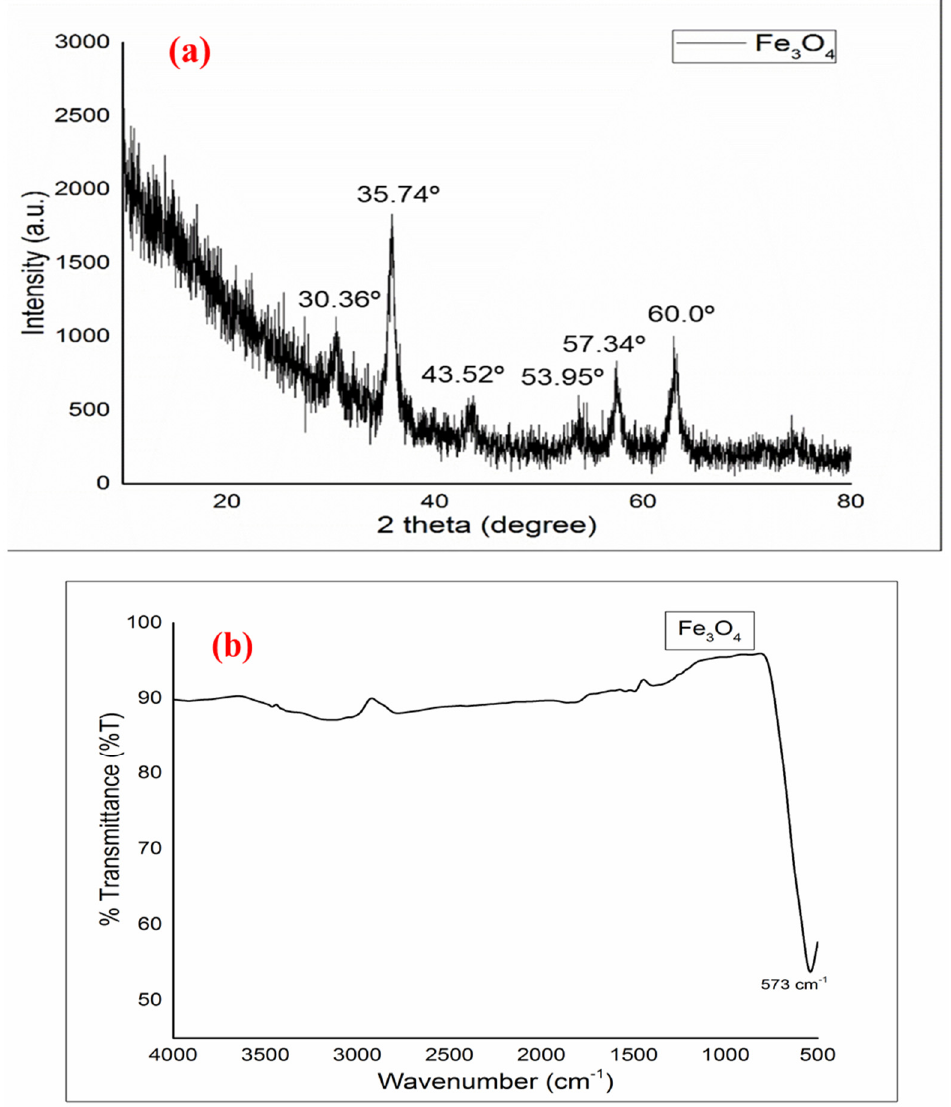
Figure 1. Haracterizations of magnetite ( a ) XRD pattern of the magnetite; ( b ) FTIR spectrum of the magnetite.